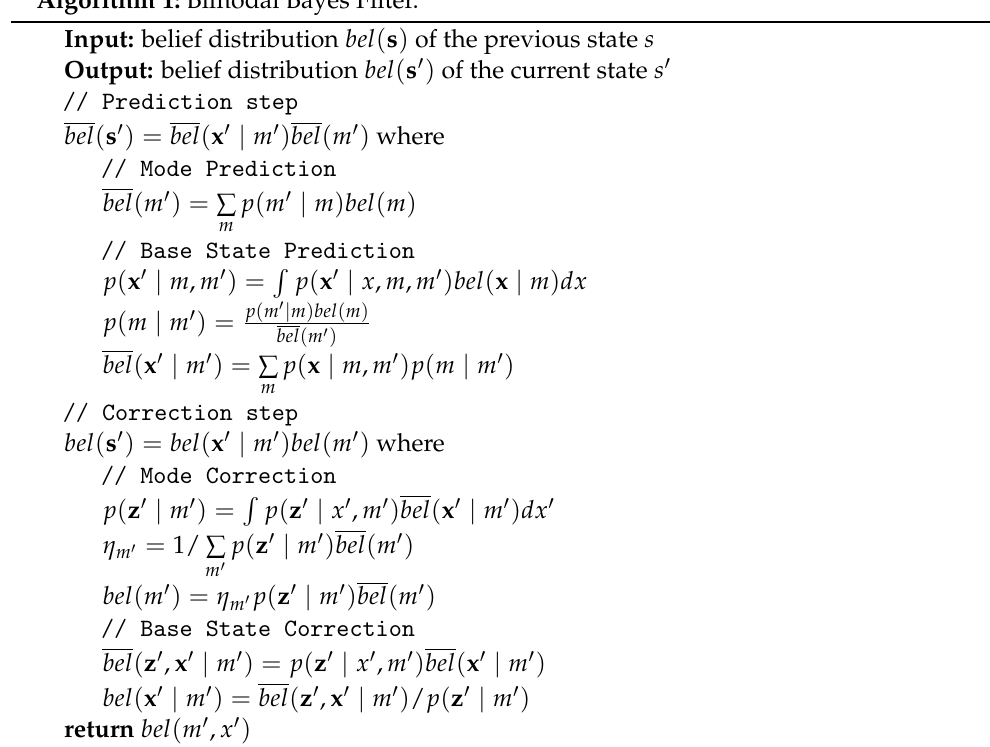
Algorithm 1: Bimodal Bayes